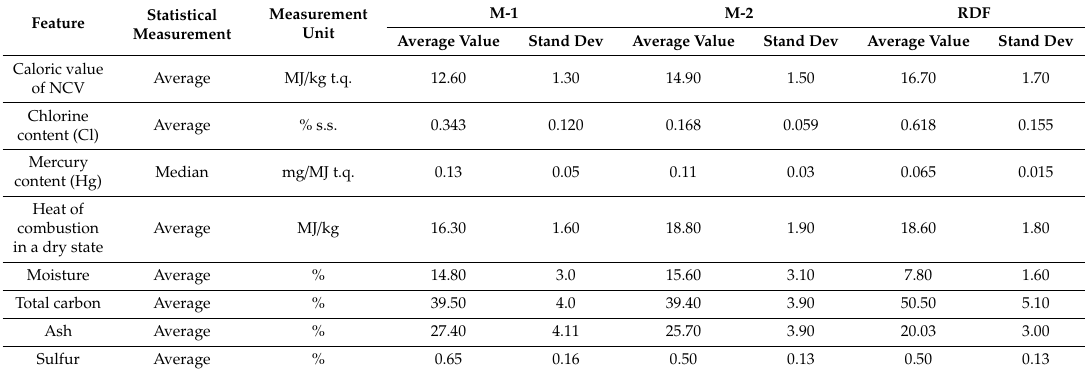
Table 4. Selected properties of M-1 and M-2 waste and RDF produced in MBT installation in Marsz ó w. Feature Statistical